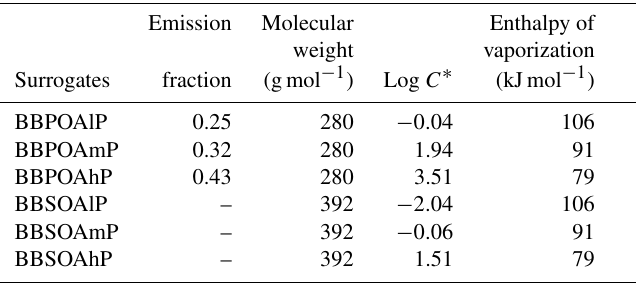
Table C2. Properties of primary and secondary